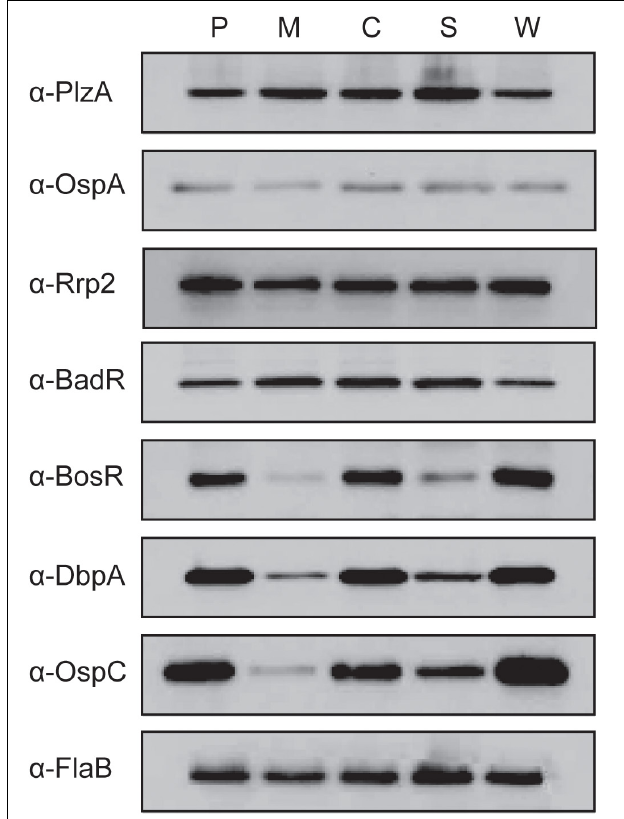
FIGURE 5 | Deletion of cyaB reduces protein production of BosR, OspC, and DbpA. Borrelia burgdorferi was grown in BSK-glycerol to mid-logarithmic phase at 32 ◦ C 1% CO 2 . Protein was harvested and resolved on SDS–PAGE with approximately 4 × 10 7 B. burgdorferi in each lane. Immunoblots were prepared using the depicted antiserum. FlaB was used as a loading control. Displayed is the representative of three independent replicates. The following abbreviations are used to indicate strains: WT (P), cyaB − (M), c- cyaB (C), c- cyaB -SR0623 (S), and c- cyaB -SR0623w (W).